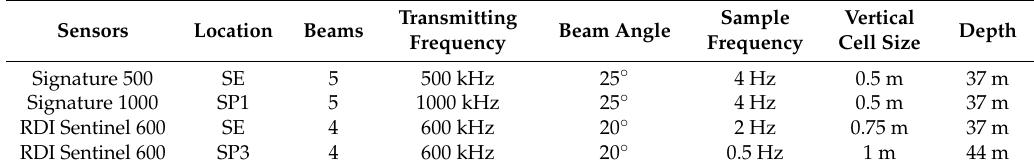
Table 1. Sensor specifications.